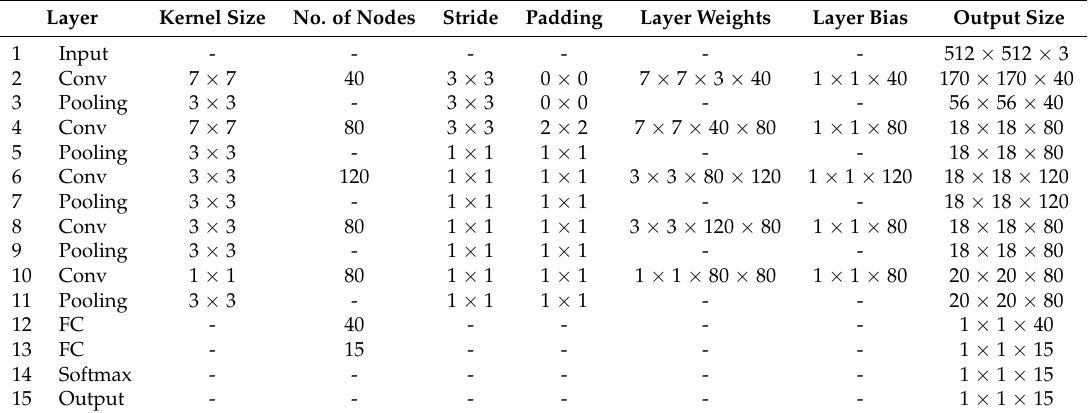
Table 4. Description of the custom CNN used as the base classifier in the AdaBoost optimisation based on [60].